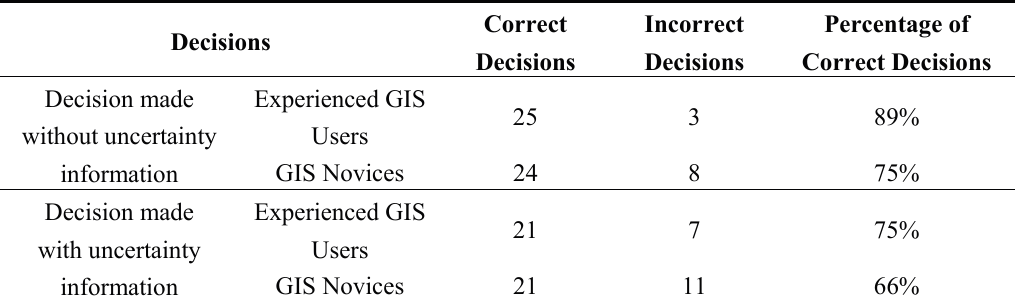
Table 2. Observed frequencies of correct and incorrect decisions made with and without the uncertainty information.